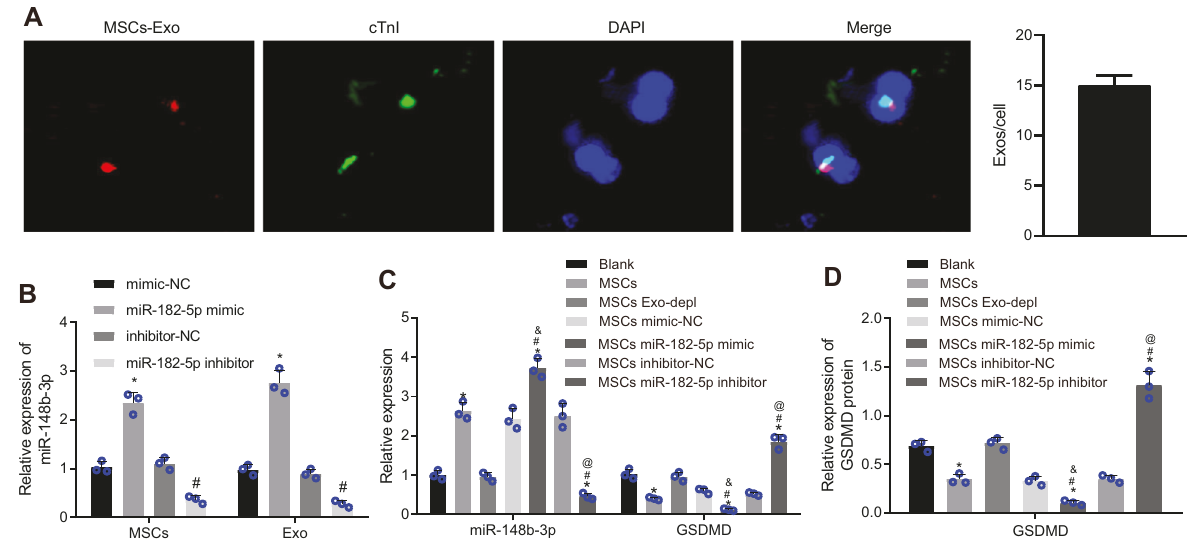
Fig. 5 Exosomal miR-182-5p from MSCs reduces GSDMD expression in myocardial cells. A The uptake of exosomes by myocardial cells observed under an inverted microscope (× 200); B The relative expression of miR-182-5p in MSCs and MSC-derived exosomes determined by RT-qPCR, normalized to U6; * P < 0.05 vs. the MSCs transfected with mimic-NC or their derived exosomes; # P < 0.05 vs. the MSCs transfected with inhibitor-NC or their derived exosomes. C miR-182-5p expression and GSDMD mRNA level in myocardial cells co-cultured with miR-182- 5p mimic/inhibitor-transfected MSCs detected by RT-qPCR, normalized to U6 and GAPDH, respectively; D Western blot analysis of GSDMD protein in myocardial cells co-cultured with miR-182-5p mimic/inhibitor-transfected MSCs, normalized to GAPDH. Measurement data were expressed as mean ± standard deviation. The comparison between two groups was performed using an unpaired t -test and comparison among multiple groups was assessed with one-way ANOVA, followed by Tukey ’ s post hoc test. Each cell experiment was repeated three times independently. * P < 0.05 vs. the blank myocardial cells, # P < 0.05 vs. myocardial cells co-cultured with non-transfected MSCs, & P < 0.05 vs. myocardial cells co-cultured with mimic-NC-transfected MSCs, @ P < 0.05 vs. myocardial cells co-cultured with inhibitor-NC-transfected